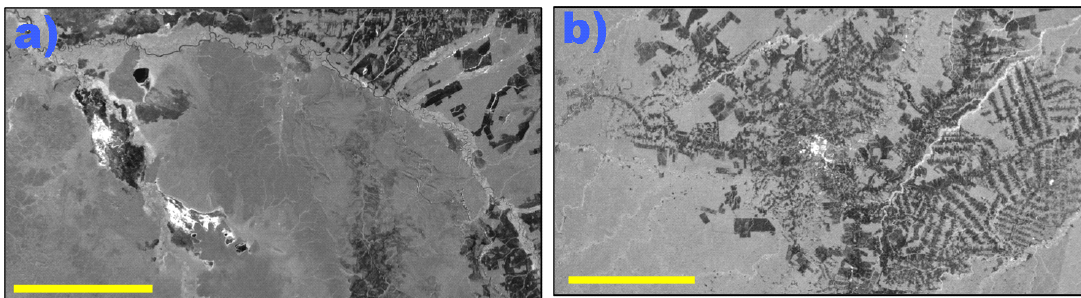
Figure 3. Orthorectified ScanSAR mosaic of most of South America, late-2006 to mid-2010. Colored letters correspond to details shown in subsequent figures. ©